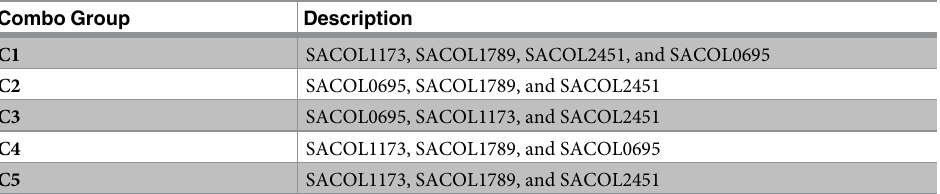
Table 1. Summary of combination